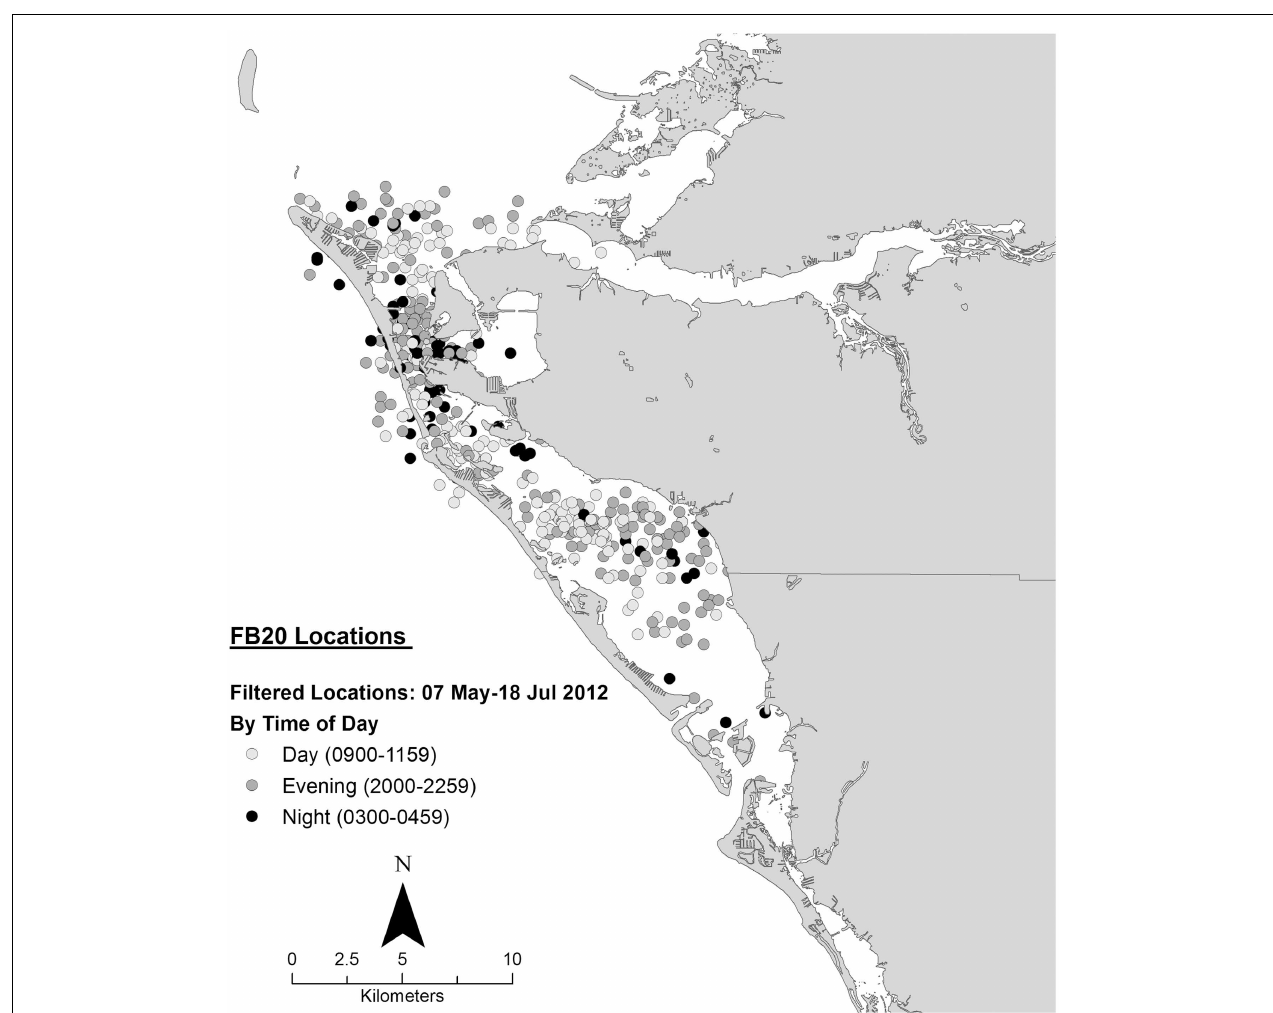
FIGURE 9 | Locations of bottlenose dolphin FB20 relative to time of day during May–July 2012, from satellite-linked transmitter .